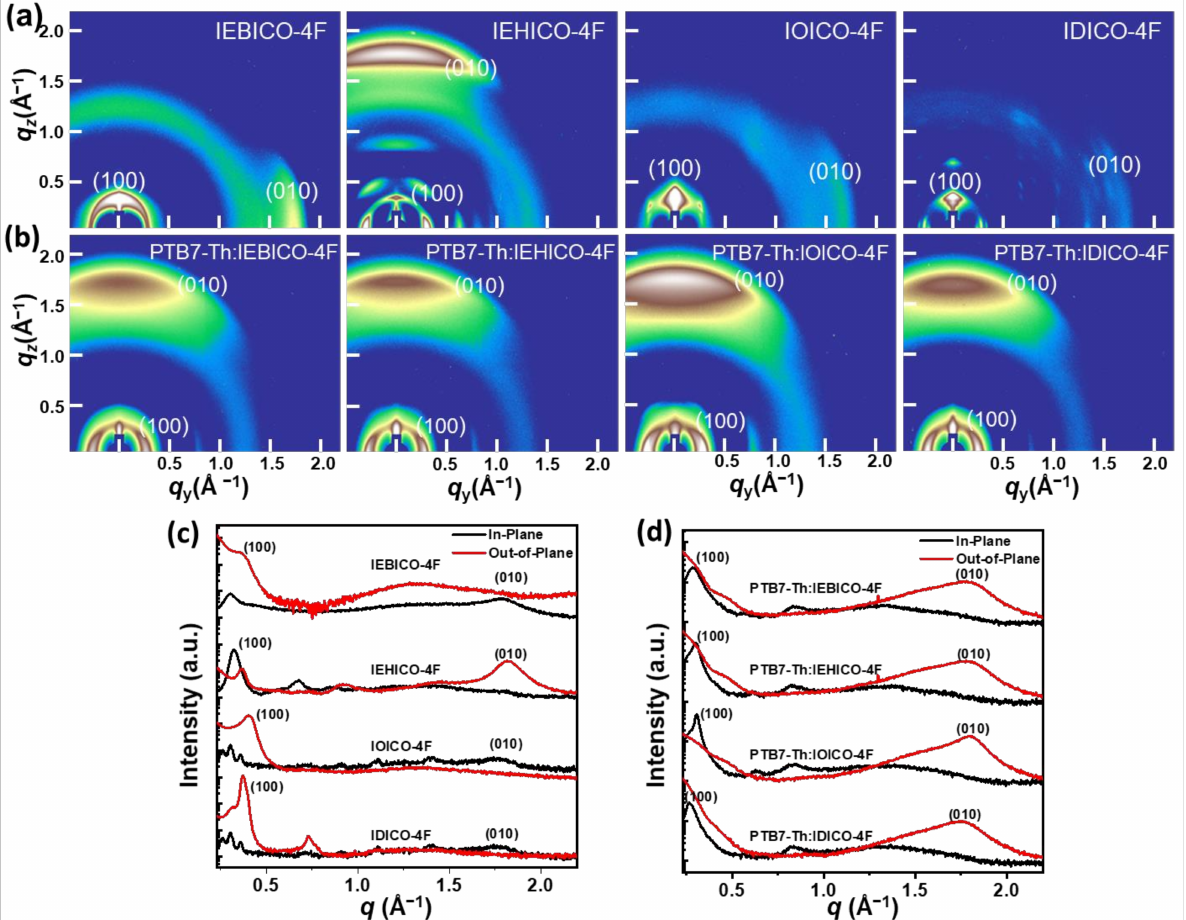
Figure 5. GIWAXS images of ( a ) IEBICO-4F, IEHICO-4F, IOICO-4F, and IDICO-4F neat films and ( b ) PTB7-Th:IEBICO-4F, PTB7-Th:IEHICO-4F, PTB7-Th:IOICO-4F, and PTB7-Th:IDICO-4F blend films. Line-cut profiles of ( c ) IRICO-4F neat films and ( d ) PTB7-Th:IRICO-4F blend